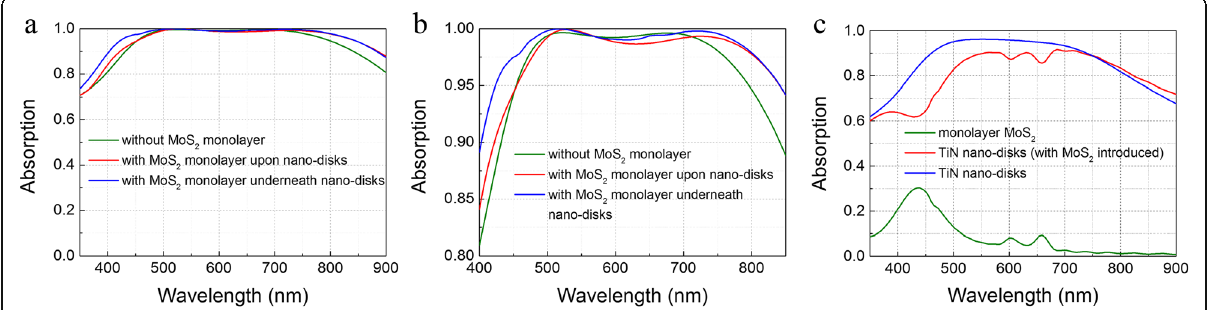
Fig. 5 The absorption spectra a and the enlarged absorption spectra b of the cases that the monolayer MoS 2 is introduced underneath TiN nano-disk array, upon the TiN nano-disks and not introduced, respectively. c The absorption of the TiN nano-disks and monolayer MoS